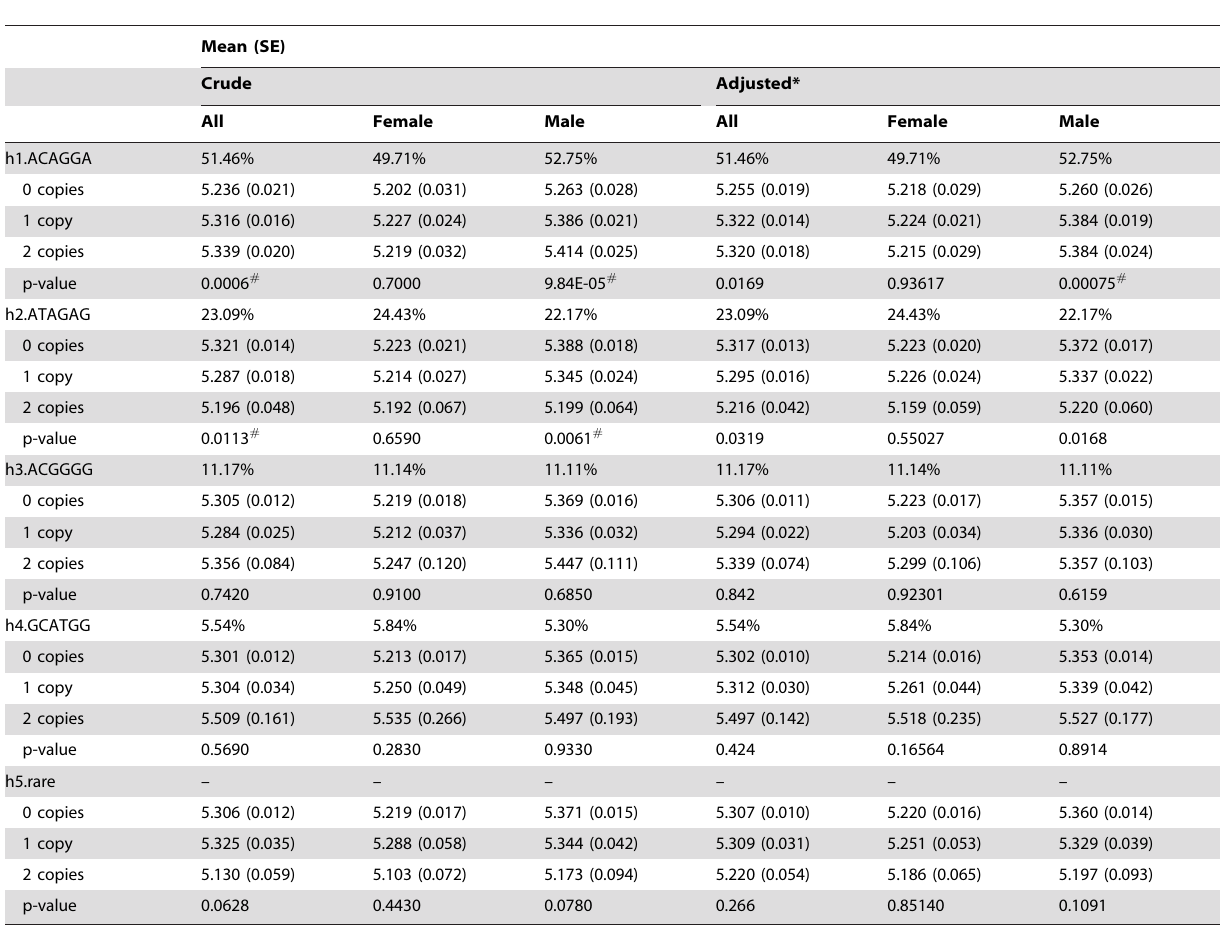
Table 3. Association between haplotypes in the CMA1 gene and natural logarithm of